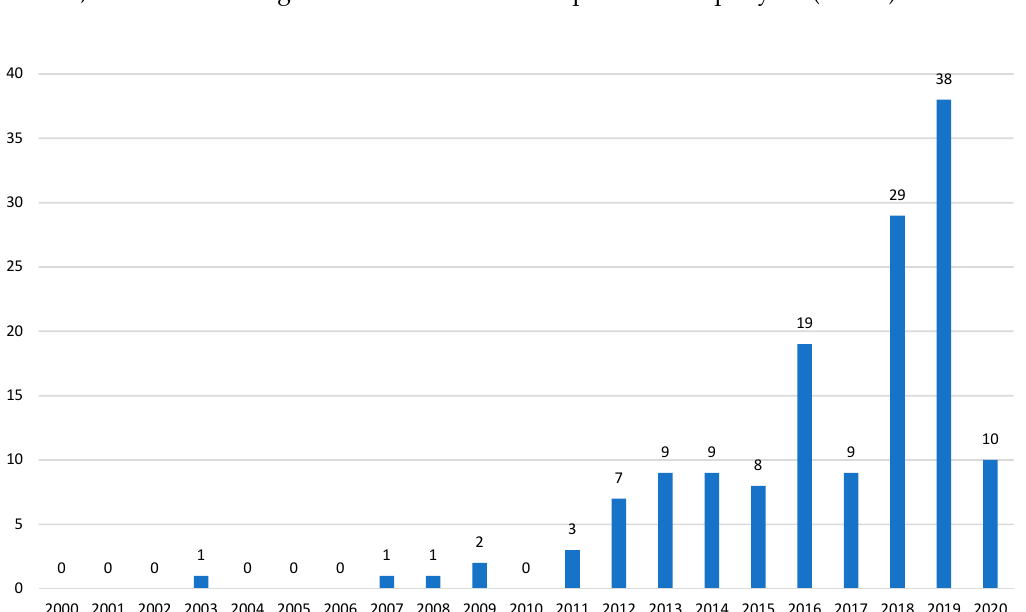
Figure 3. Absolute number of articles on the subject within the investigated time frame.